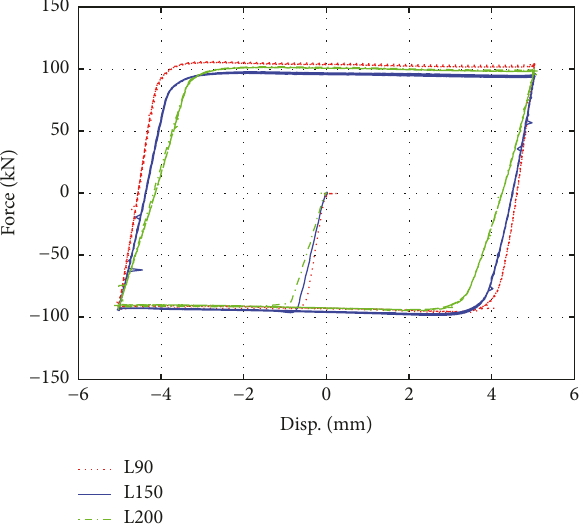
Figure 8: Force-displacement curves of the three specimens with different bolt pitches.